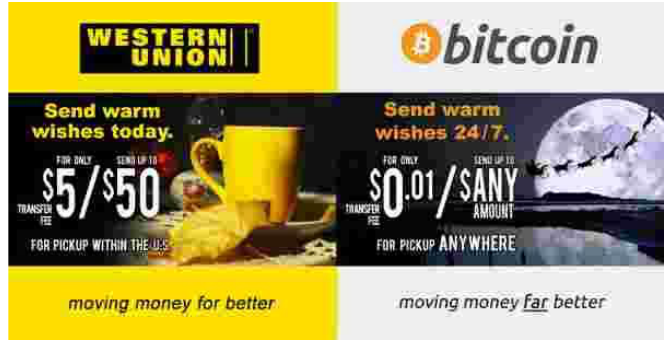
Fig. 3. This JPEG image is stored in Bitcoin’s blockchain as a GZIP archive file